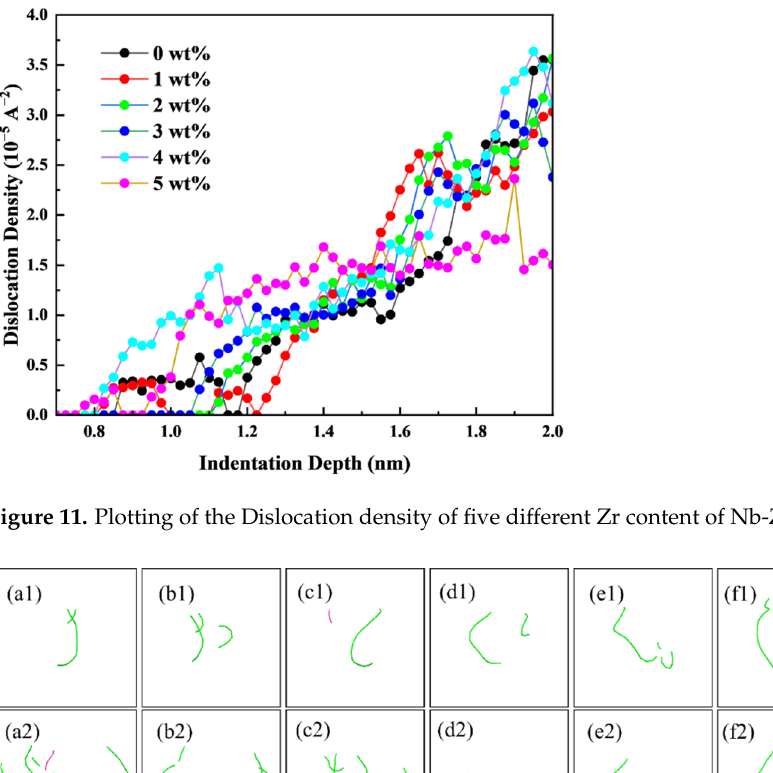
Figure 10. Comparison of reduced elastic modulus and elastic modulus between room temperature (296 K) and high temperature (1470 K) for different Zr content. ( a ) room temperature; ( b ) high tem- perature.